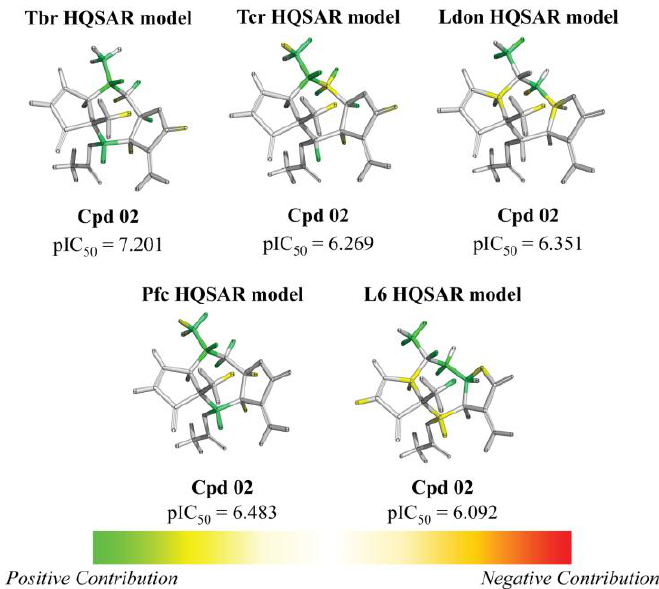
Figure 4. HQSAR maps of positive contribution for all 5 constructed HQSAR